Question: Condense the content of this figure into a single sentence.
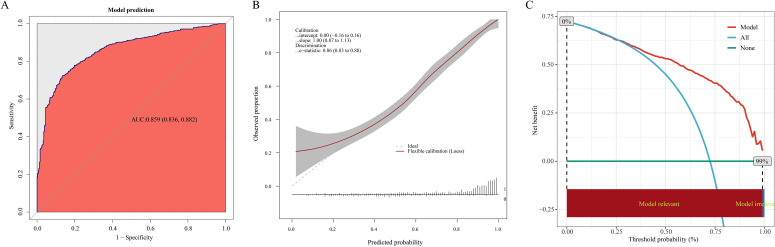
Answer: Apparent performance of the final atrial fibrillation classification model. (A) Receiver operating characteristic curve; (B) calibration curve; (C) decision-curve analysis.